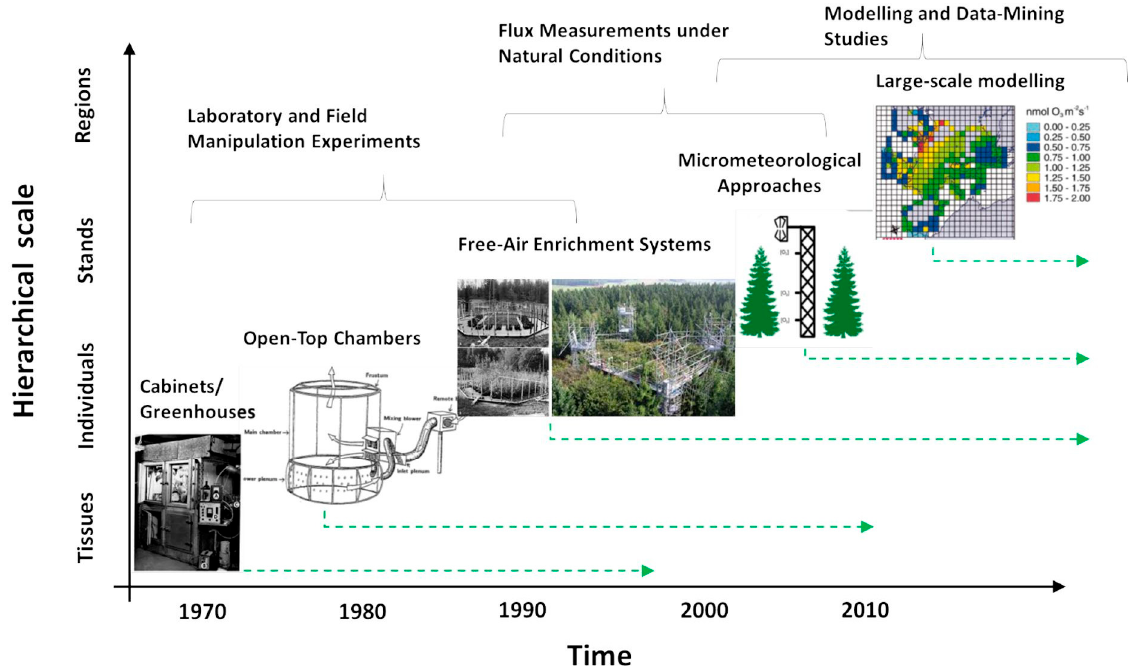
Figure 2. The scheme suggests a time development of methodological approaches applied to examine the plant responses to O 3 in relation to a transition from tissue-level studies, through studies at the level of individuals and stands, up to large-scale modelling.